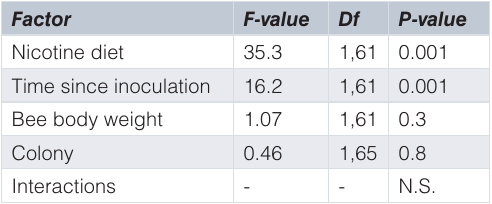
Table 1. “Continuous Exposure” test: results from GLMM analysis of C. bombi population